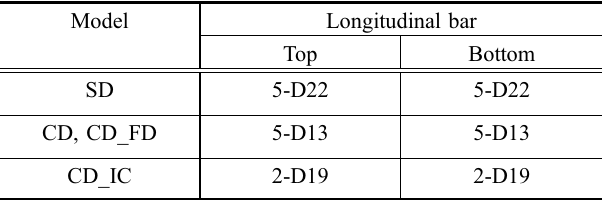
Table 2 Member size and rebars of the second story cou- pling beams in the frame A.